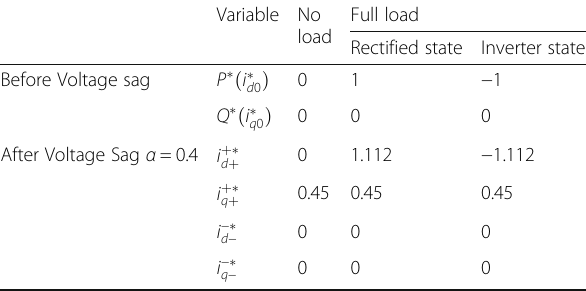
Table 3 Low voltage ride through parameters of voltage asymmetric sag